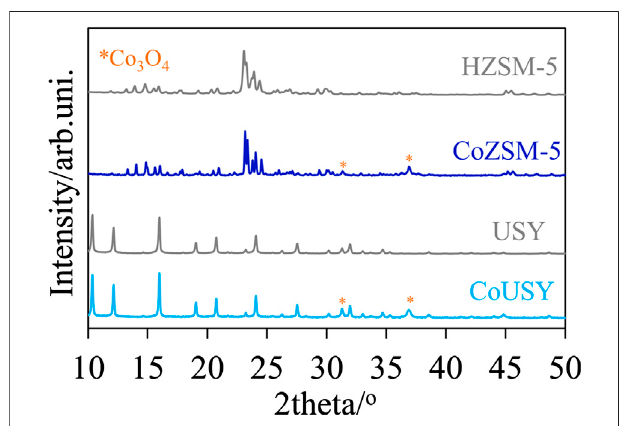
FIGURE 1 | XRD patterns of the CoUSY and CoZSM-5 catalysts as well as reference zeolite supports.